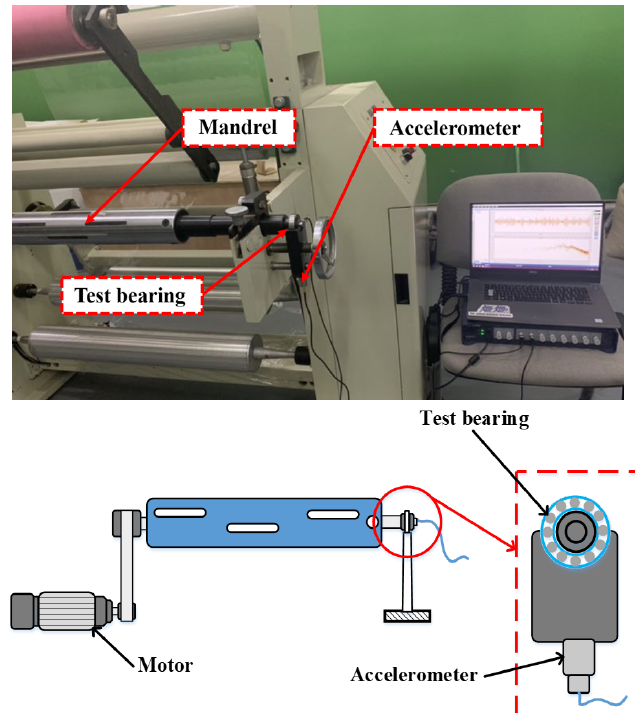
Figure 9. The bearing test rig of press